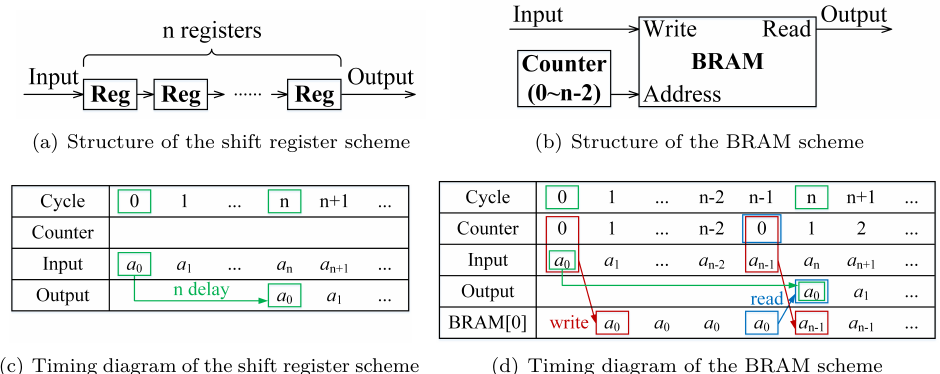
Figure 8: Two implementation schemes for an n-cycle delay